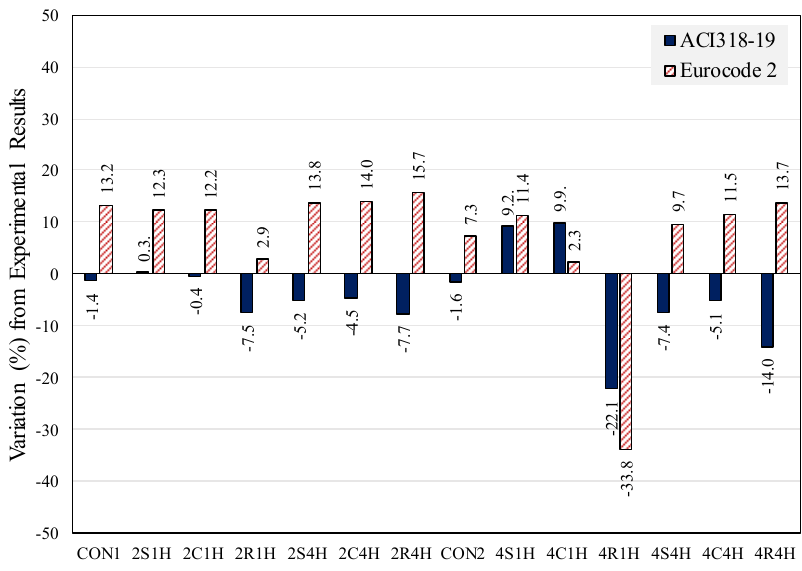
Figure 19. Variation (%) of theoretical predictions from experimental results.